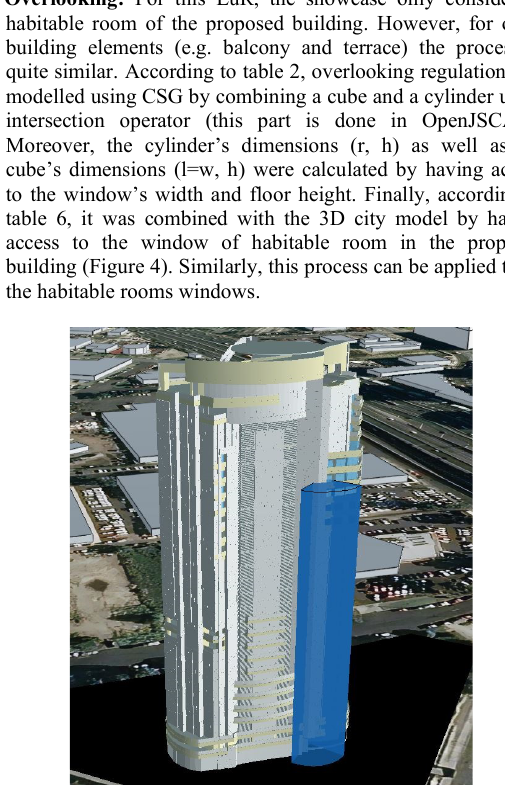
Figure 4 . Overlooking regulation in 3D using CSG